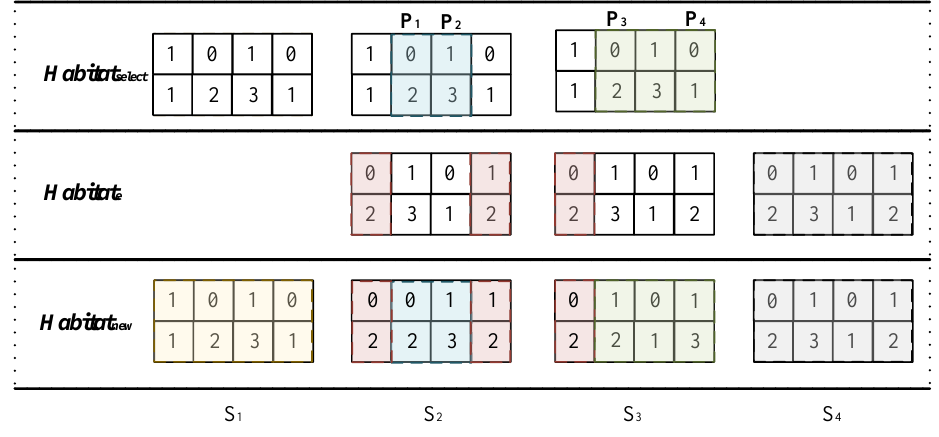
Figure 5. Upper-level algorithm coding schematic.